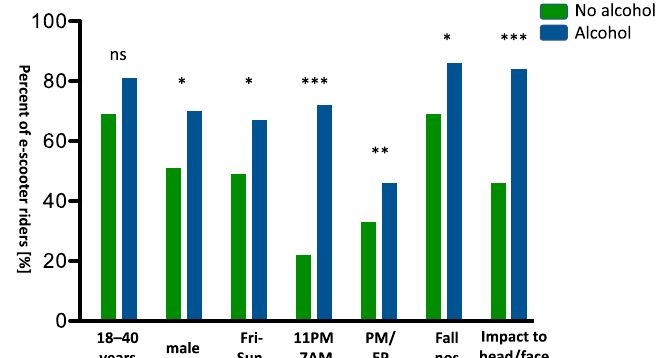
Figure 2. Bar graph depicting sober e-scooter riders vs. those under the influence of alcohol. Depicted as bars in percent of total of those aged between 18 and 40 years, male sex, crashes between Friday and Sunday, crash time between 11 PM and 7 AM, mode of presentation by ambulance/paramedics (PM) or emergency physician (EP), crash mechanism "fall, not otherwise specified (nos)” and impact to head and face. Statistical analysis